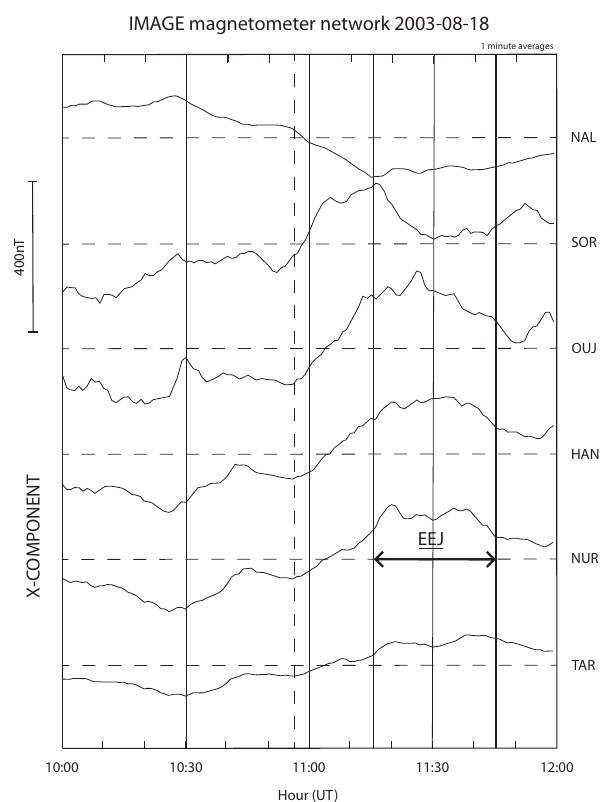
Figure 9. IMAGE chain magnetometer data ( X -component de- flections) from stations NAL (75.4 ◦ MLAT), SOR (67.3 ◦ MLAT), OUJ (61.0 ◦ MLAT), HAN (58.7 ◦ MLAT), NUR (56.9 ◦ MLAT), and TAR (54.5 ◦ MLAT). The interval of enhanced EEJ activity (11:17– 11:45UT) at auroral oval south stations (HAN–NUR) is marked by vertical guidelines. The activity in the polar cap (NAL) and aur- oral oval north-expanded cleft (SOR) during the interval 10:57– 11:17UT is attributed to the dayside convection